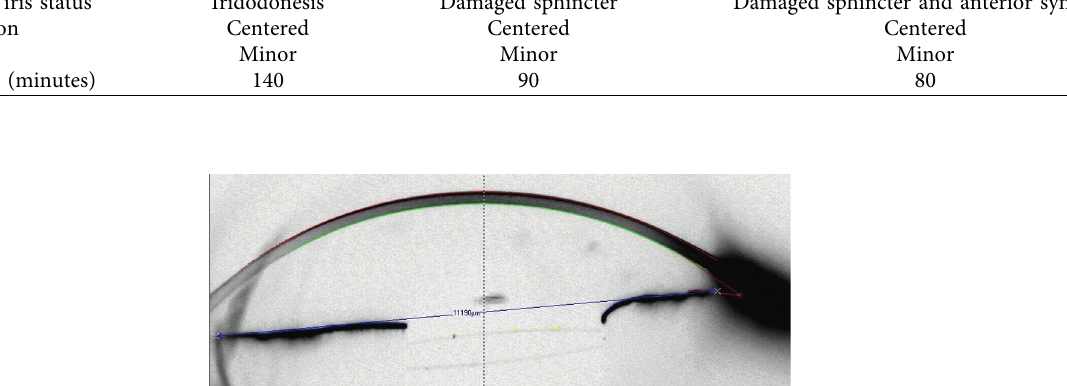
Figure 2: Scheimpflug image of patient 2 in the horizontal meridian with a well-centered IOL and only minor tilt (the blue line connects each angle and is more reliable due to the damaged iris to assess the IOL